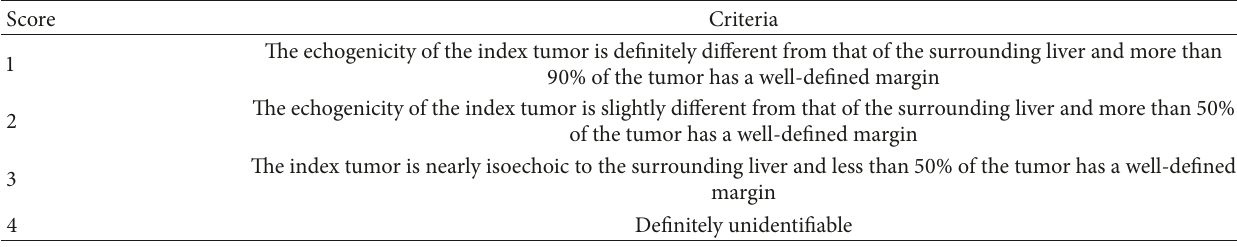
Table 1: Scoring criteria for evaluation of tumor